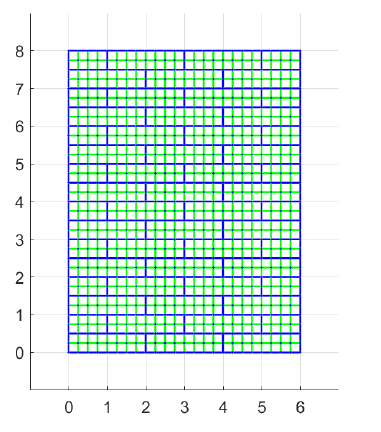
Figure 19. Potential discontinuities assuming non-rigid blocks with a refined discretization: blue lines represents discontinuities belonging to mortar joints and the green ones discontinuities within the blocks. (Dimensions expressed in units.)